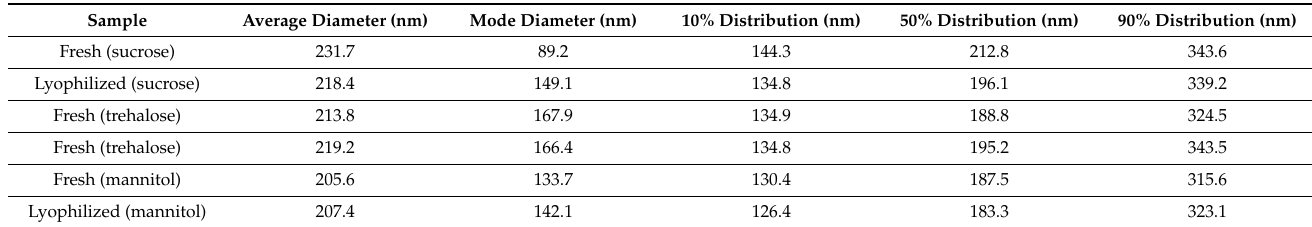
Table 2. Size distribution profile of EV present in fresh and lyophilized MSC-SP